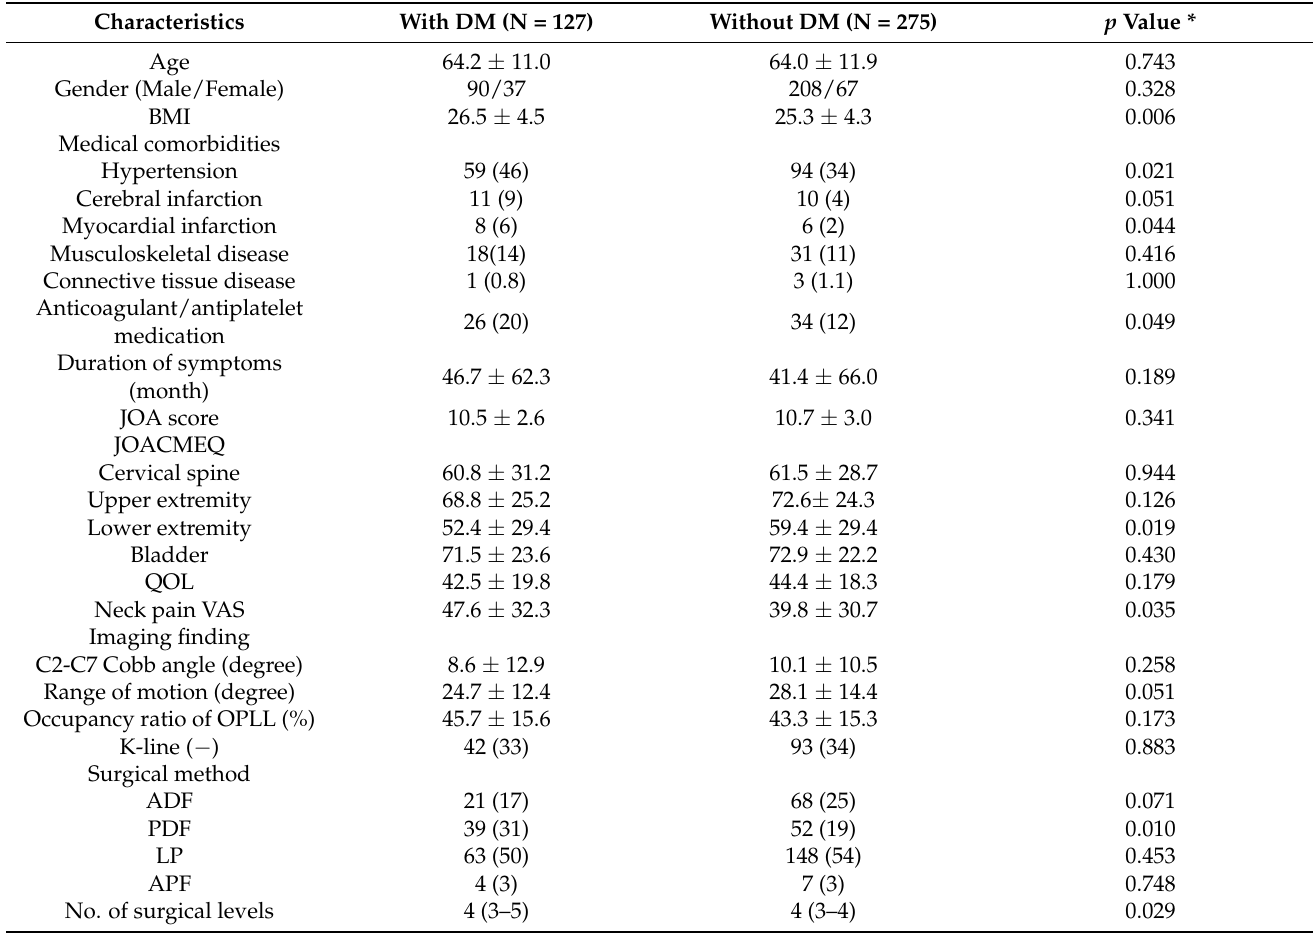
Table 1. Patients’ characteristics and baseline